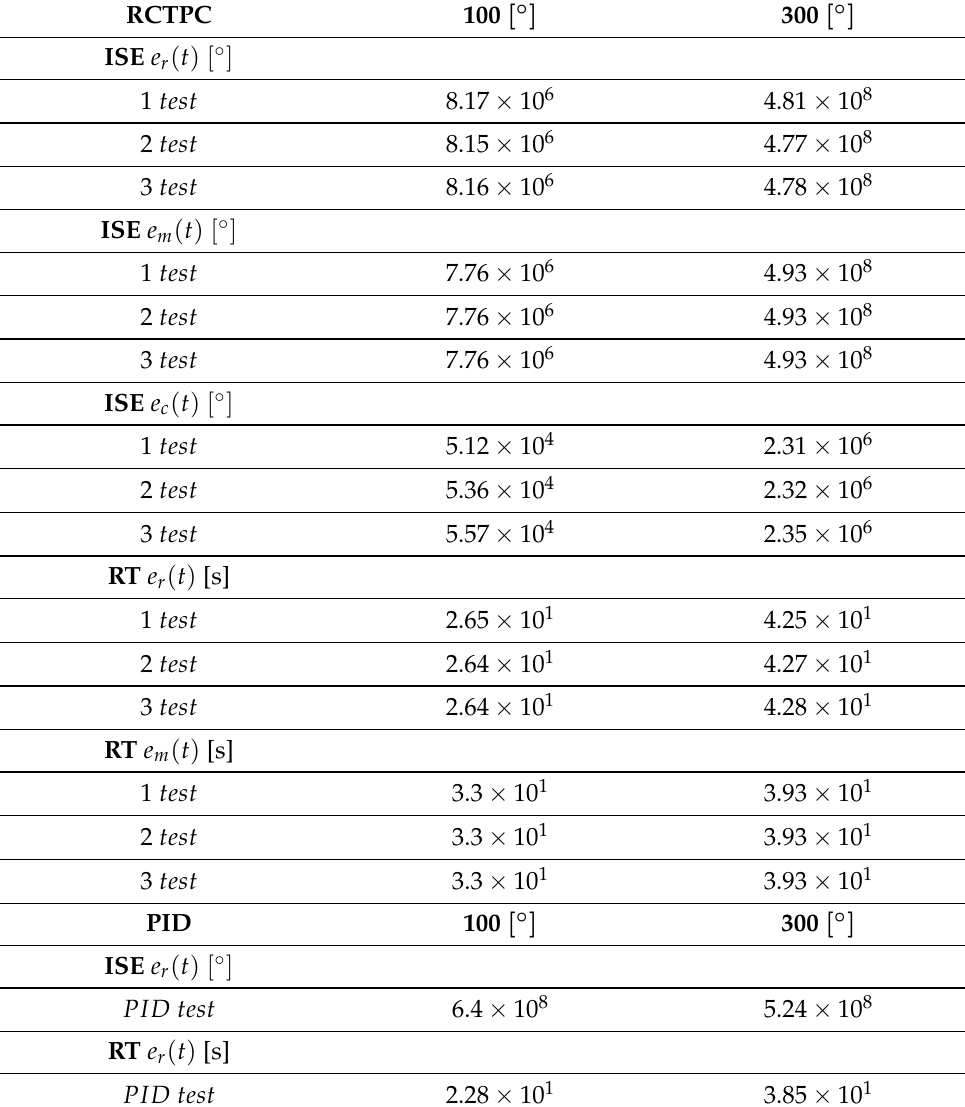
Table 4. The results of the performance